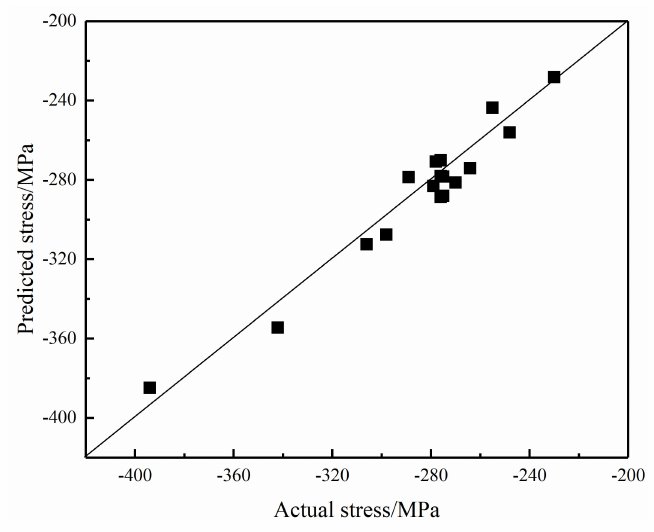
Figure 6. Scatter plot between the actual and predicted